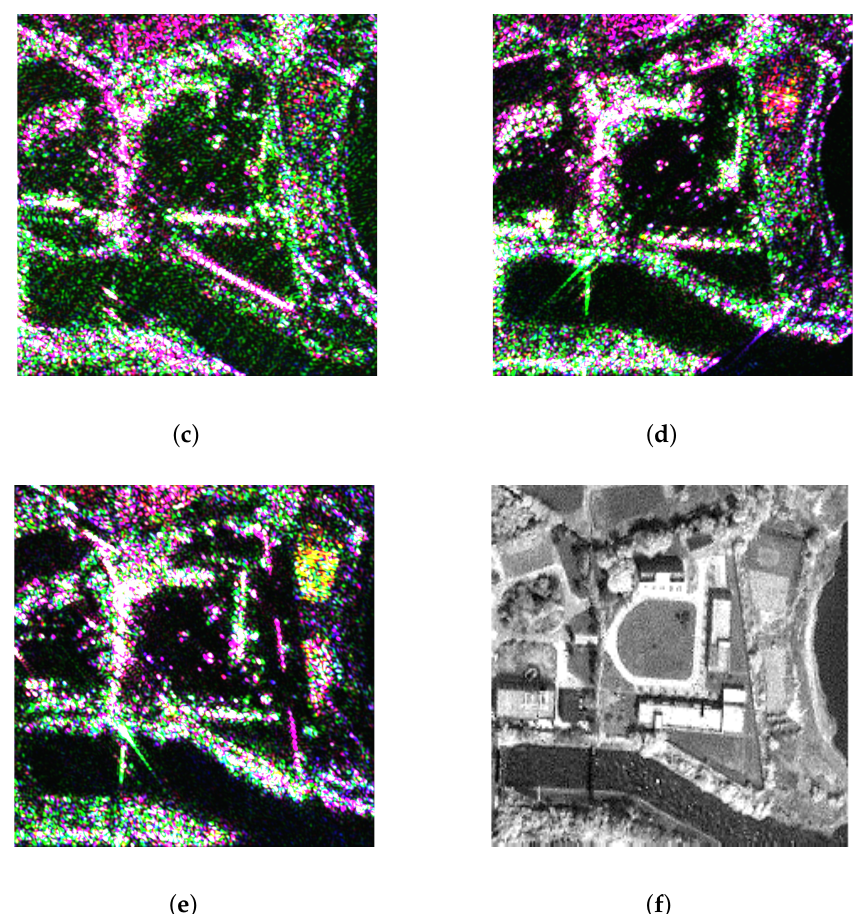
Figure 4. ( a ) Full aperture; ( b ) 0 ◦ –10 ◦ sub-aperture; ( c ) 90 ◦ –100 ◦ sub-aperture; ( d ) 180 ◦ –190 ◦ sub-aperture; ( e ) 270 ◦ –280 ◦ sub-aperture images using Pauli basis (blue: | H + V | ; red: | H − V | ; green: 2 | HV | ); and ( f ) optical